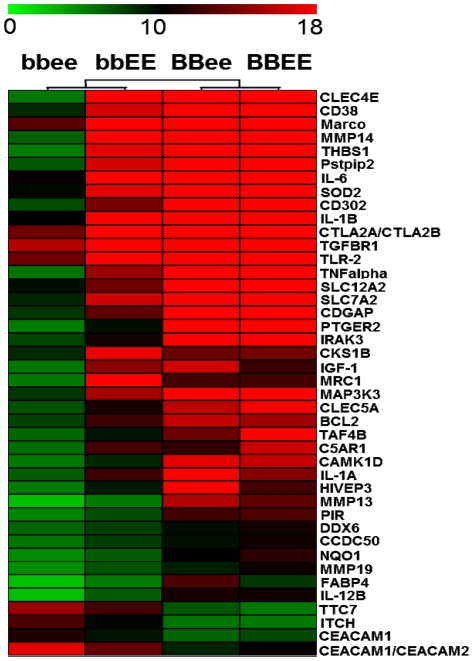
Cluster analysis of microarray data of bone marrow derived macrophages stimulated with LPS and mIFNγ.Expression data established from activated macrophages revealed a total of 145 genes that were collectively deregulated in the comparison of cells from either wild-type (BBEE), C/EBPβ−/− (bbEE), or C/EBPε−/− (BBee) with C/EBPβ−/−C/EBPε−/− (bbee). Cluster analysis performed with Multi Experiment Viewer (MeV) v4.4.1 indicates 45 of the most deregulated genes out of the collective of 145 genes.